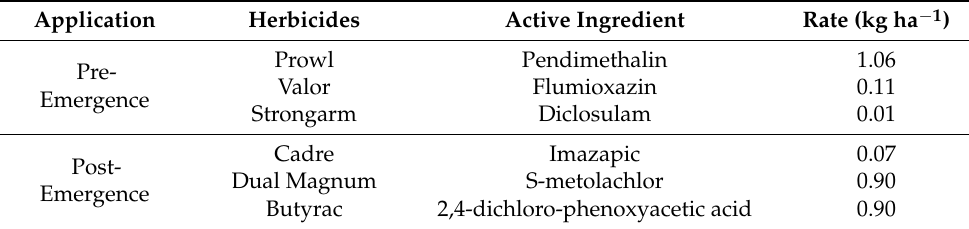
Table 1. Information on different herbicides and their corresponding active ingredient rates applied during the spray testing conducted in 2021 and 2022.